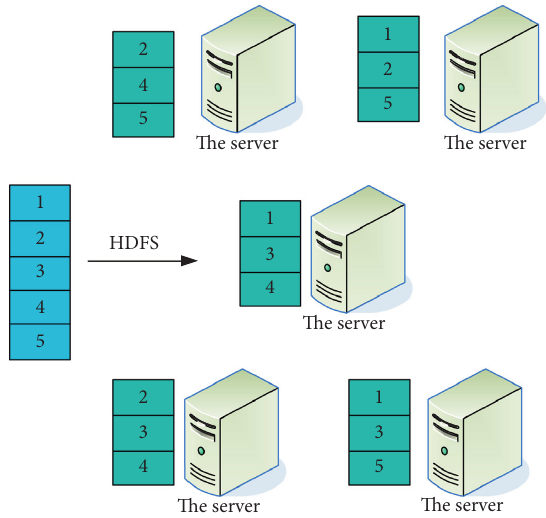
Figure 1: Hadoop distributed file